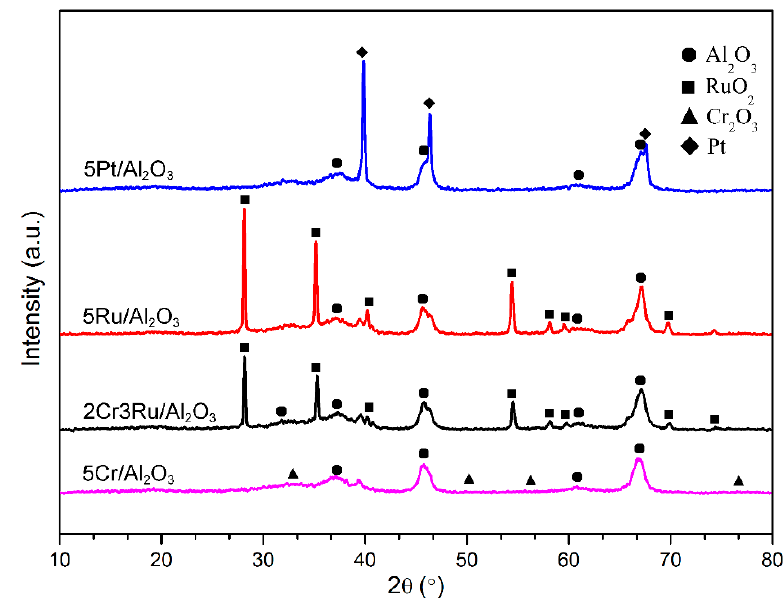
Figure 3. PXRD patterns of fresh 5Pt, 5Ru, 5Cr, and 2Cr3Ru supported on Al 2 O 3 .